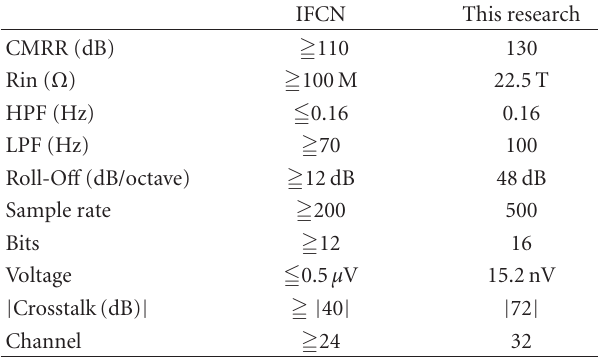
Figure 10: Reference ground barrier of PCB. Table 1: Proposed system compare with IFCN